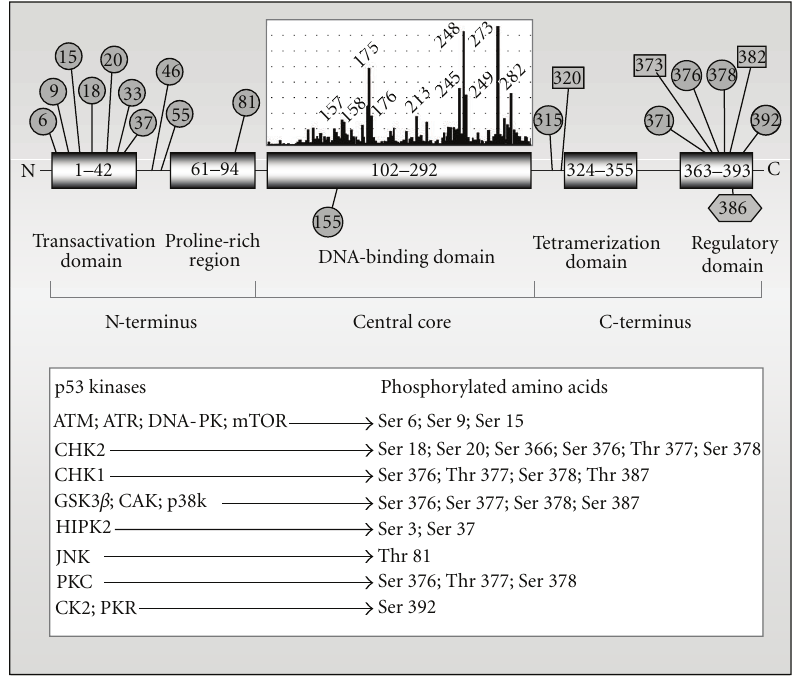
Figure 1: Structure and posttranscriptional modification of the human p53 protein. Circles, Ser/Thr phosphorylation sites; squares, acetylation sites; hexagon, SUMOylation site. The insert vertical bars above the DNA-binding domain illustrate the distribution and the prevalence of point mutations found in p53 in human cancers [19, 20]. The most frequently mutated codons (“hotspot” codons) are identified. Several proteins that phosphorylate p53 and the target amino acids of p53 are also shown in the box [21]. ATM, ataxia- telangiectasia mutated; ATR, ataxia-telangiectasia and RAD3 related; DNA-PK, DNA-dependent protein kinase; mTOR; mammalian target of rapamycin; CHK1 and 2, checkpoint kinases 1 and 2; p38k, p38 kinase; GSK3 β , glycogen synthase kinase-3 beta; HIPK2, homeodomain interacting protein kinase 2; JNK, c-Jun-NH(2)-terminal kinase; PKC, protein kinase C; CK2, casein kinase 2; PKR, protein kinase